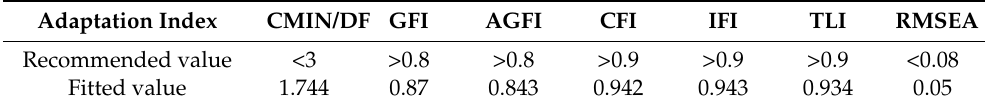
Table 9. Results of the model fitting.